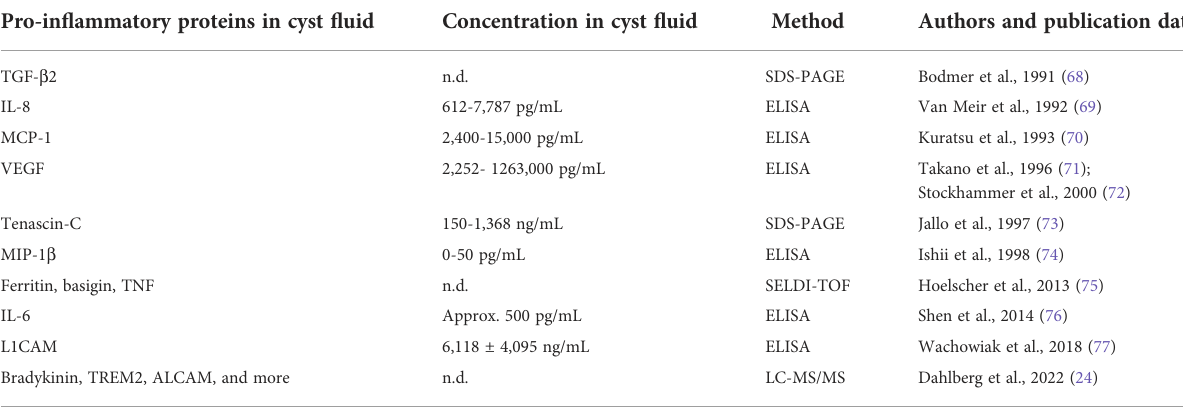
TABLE 4 In fl ammation-related proteins identi fi ed in cyst fl uid from cystic glioblastomas, as reported in the literature. Pro-in fl ammatory proteins in cyst fl